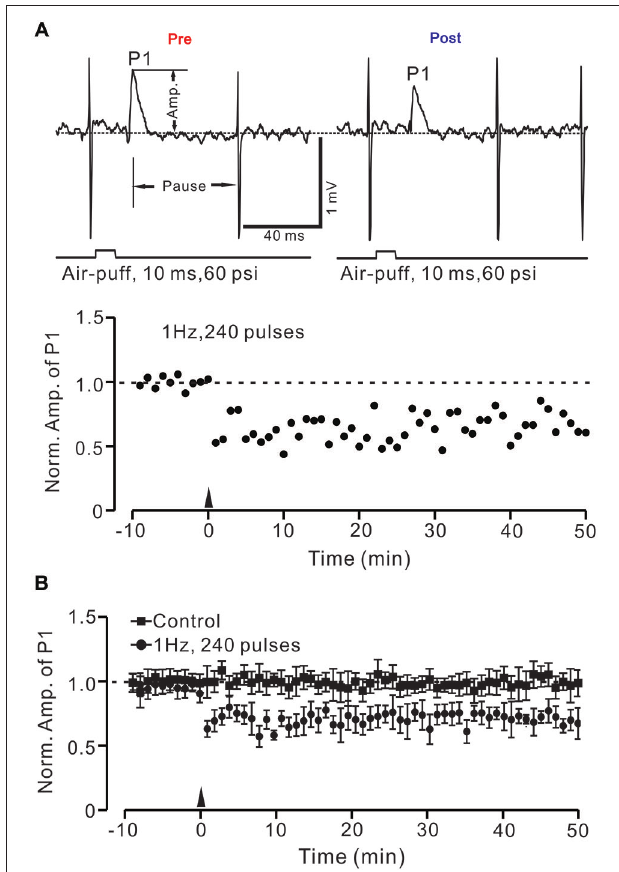
FIGURE 2 | Facial stimulation (1 Hz) induces long-term depression (LTD) of GABAergic transmission at PCs in mouse cerebellar cortex . (A) Upper, representative cell-attached recording traces showing air-puff stimulation (10 ms, 60 psi)-evoked responses in a cerebellar PC before (pre) and after (post) delivering 1 Hz (240 pulses) stimulation. Note that both amplitude of the positive component (P1) and the pause of SS firing are significantly decreased after 1 Hz stimulation. The lower panel shows the time course of normalized amplitude of P1 (shown in upper) before and after delivery of 1 Hz facial stimulation (arrow head). (B) Summary of normalized P1 amplitude under control conditions (squares; n = 7) and delivery of 1 Hz facial stimulation (arrow head; circles; n = 8). Note that air-puff stimulation at 1 Hz induced LTD of P1 in cerebellar PCs. Data points are mean ± SEM.